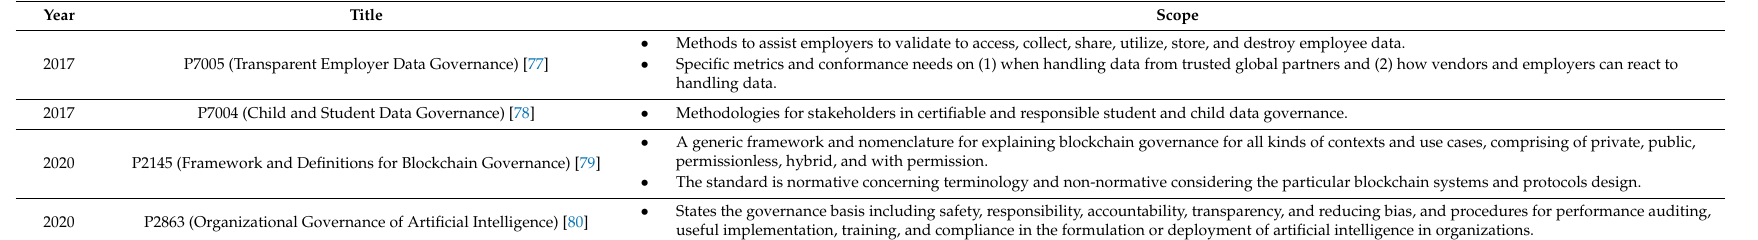
Table 5. Recent IEEE Standards in development for smart